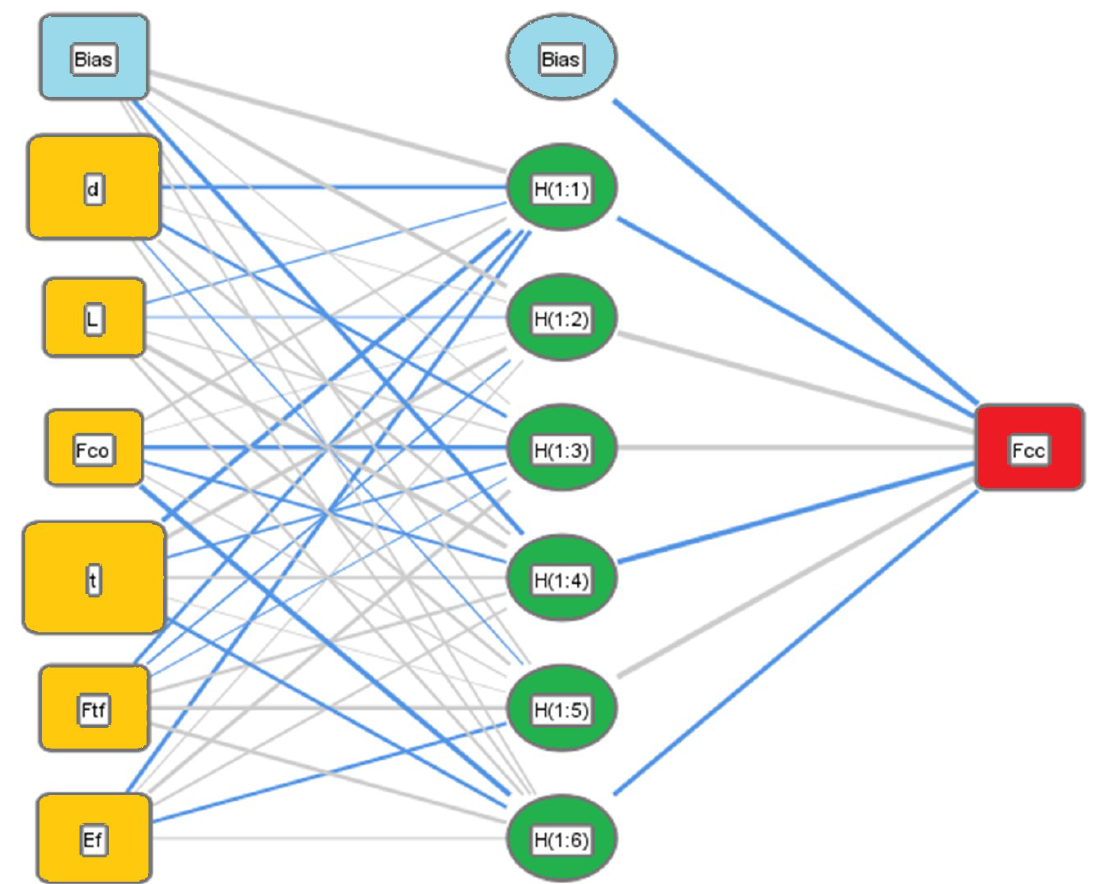
Figure 3. Architecture layout for the developed ANN models.